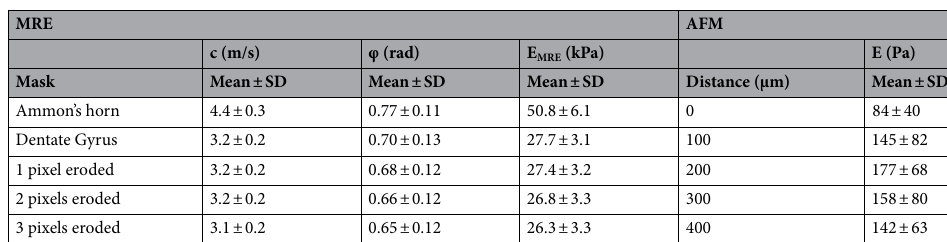
Table 1. Mean and standard deviation (SD) for c (m/s), φ (rad) and Young’s modulus (kPa or Pa). On the left, mean and SD of c (m/s) and φ (rad) and Young’s modulus (E MRE = 3 · |G*|) of the Ammon’s horn and DG masks and the DG masks reduced by 1 to 3 pixels from in vivo MRE, n = 10. On the right, mean and SD are given for distances from peak fluorescence intensity (in μm) from ex vivo AFM, 0 μm n = 15, 100 μm n =